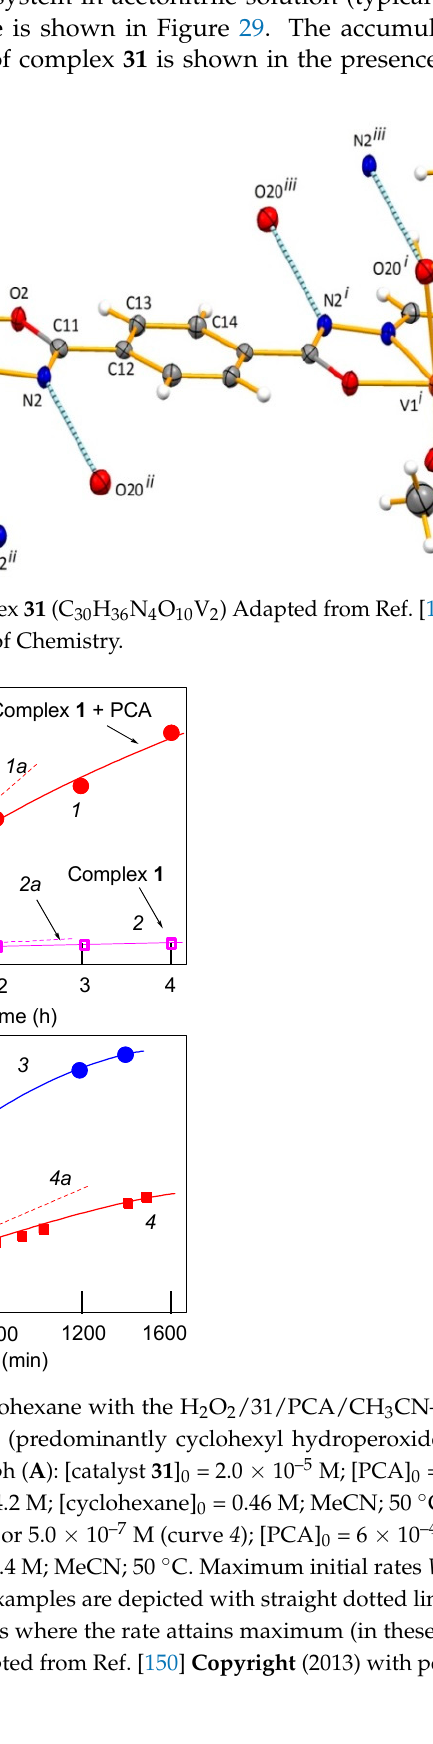
26 of 39 Figure 27. Scheme of oxidation of dopamine.